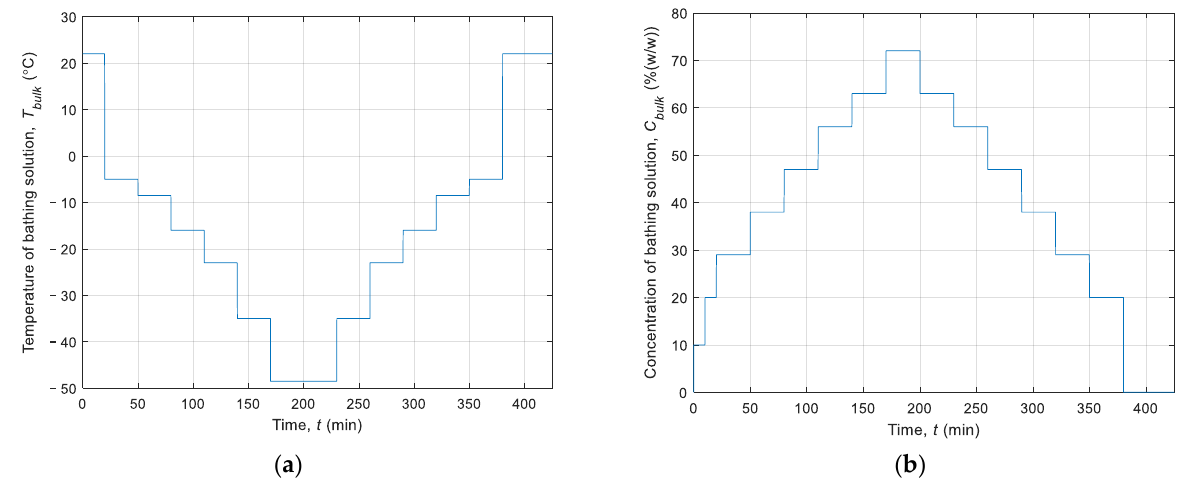
Figure 3. History of ( a ) the temperature and ( b ) the concentration of the bathing solution.